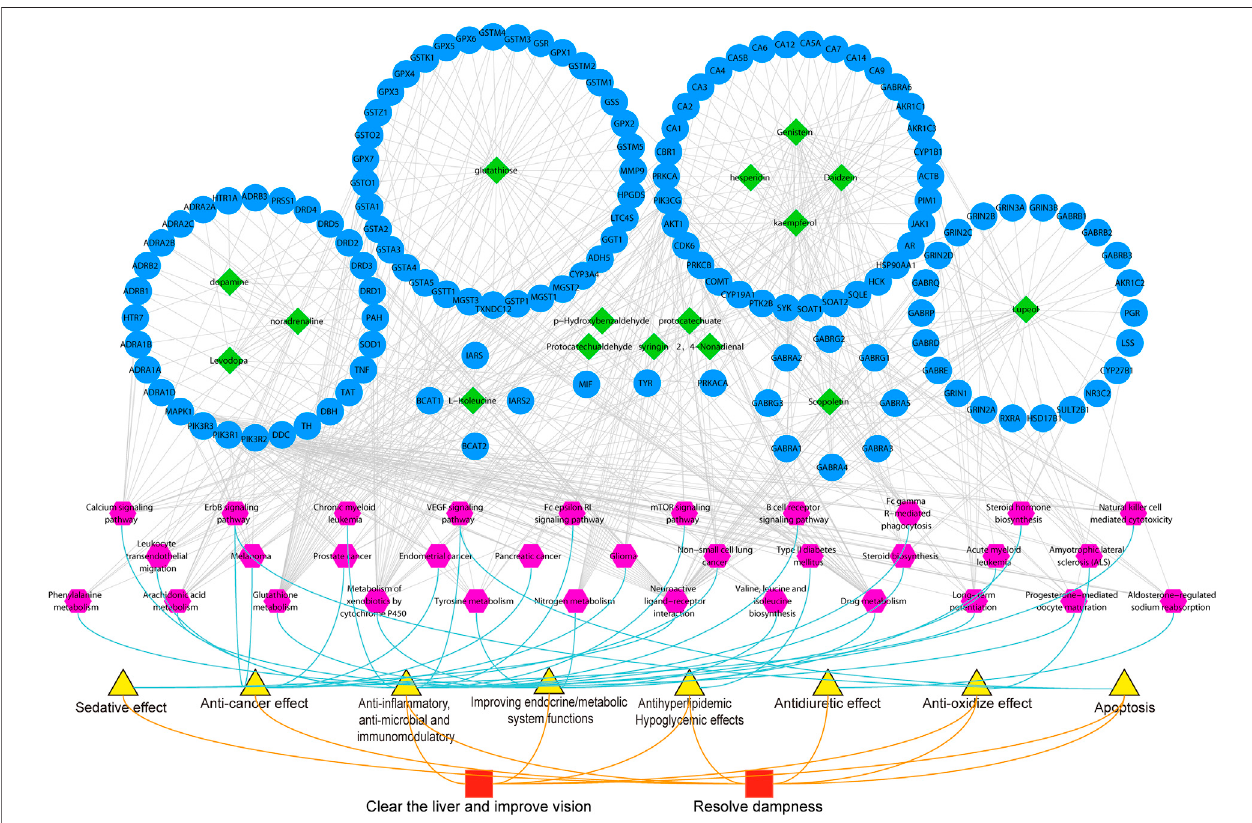
FIGURE 6 | Explain the correlation among the chemical components of MCXZ and the therapeutic ef fi cacy of TCM theory was analyzed based on network pharmacology.GreennodeindicatesthechemicalcomponentscontainedinMCXZ;BluenoderefertothetargetsofMCXZ;Purplenodereferstothepathwaysinvolved by MCXZ putative targets; the yellow node refers to the pharmacological action of MCXZ; Red node refers to the therapeutic effect of MCXZ according to the theory of TCM.